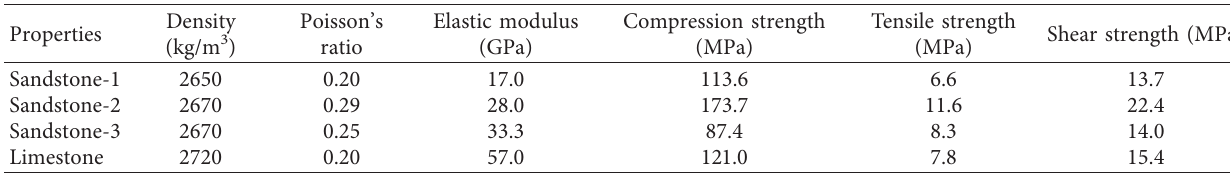
Table 2: Mechanical properties parameters of the rock